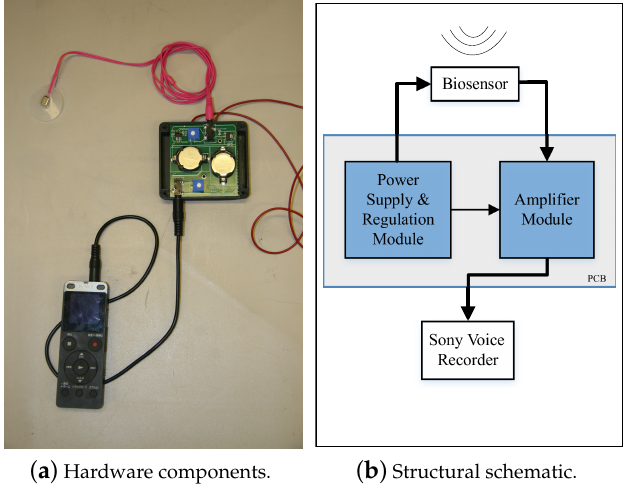
Figure 1. The physical prototype and schematic design of the NSA.